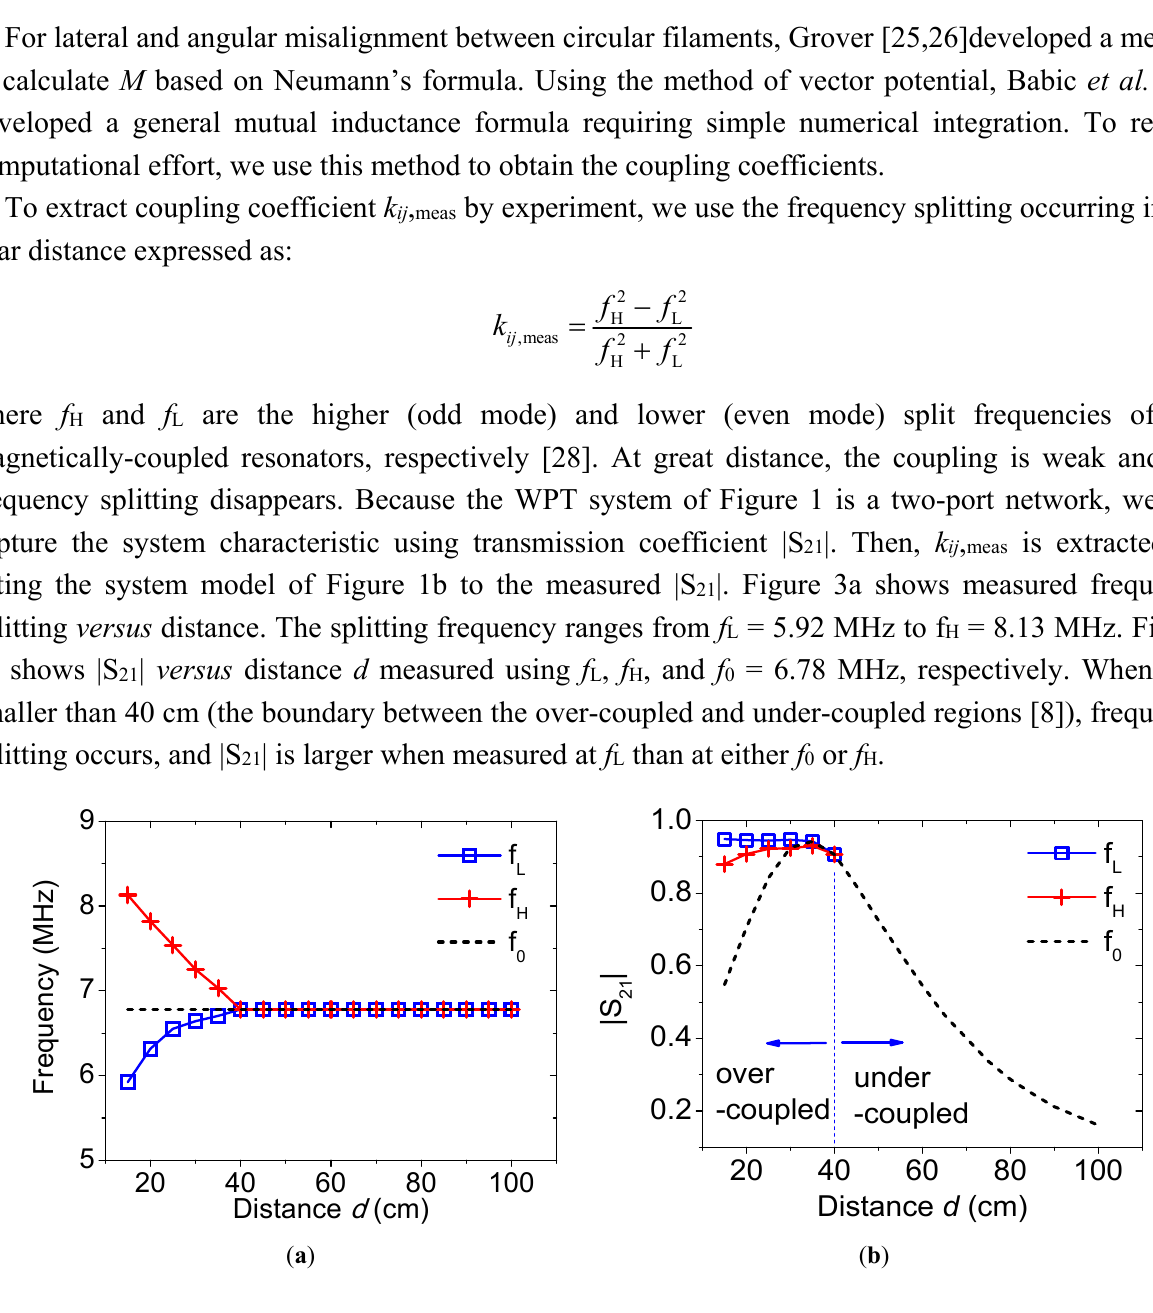
Figure 3. ( a ) Measured frequency splitting versus distance; and ( b ) measured |S 21 | versus distance under the frequency-splitting